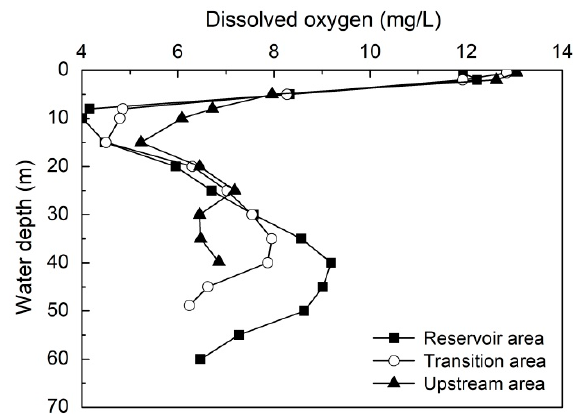
Figure 8. The vertical distribution of DO concentration in the Reservoir area (S1 site), transition area (S2 site) and upstream area (S3 site) in May 2018.